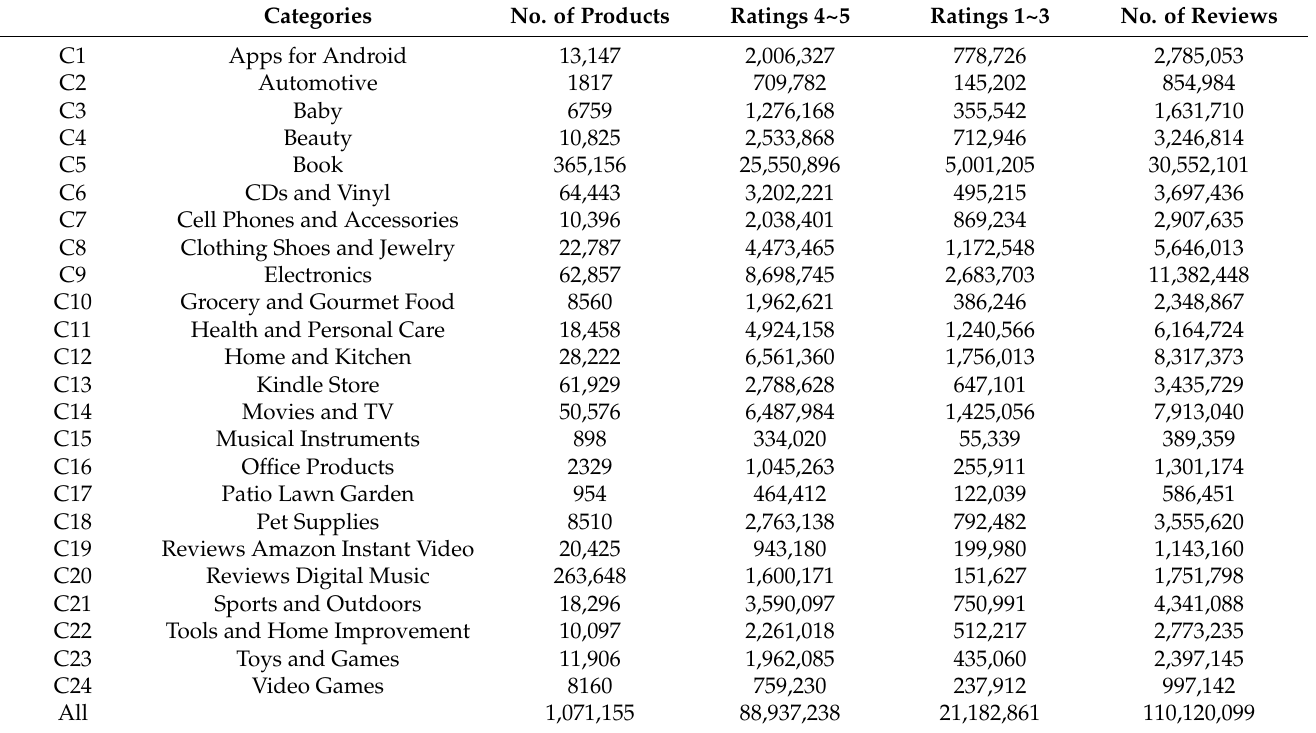
Table 1. Twenty-four categories of Amazon